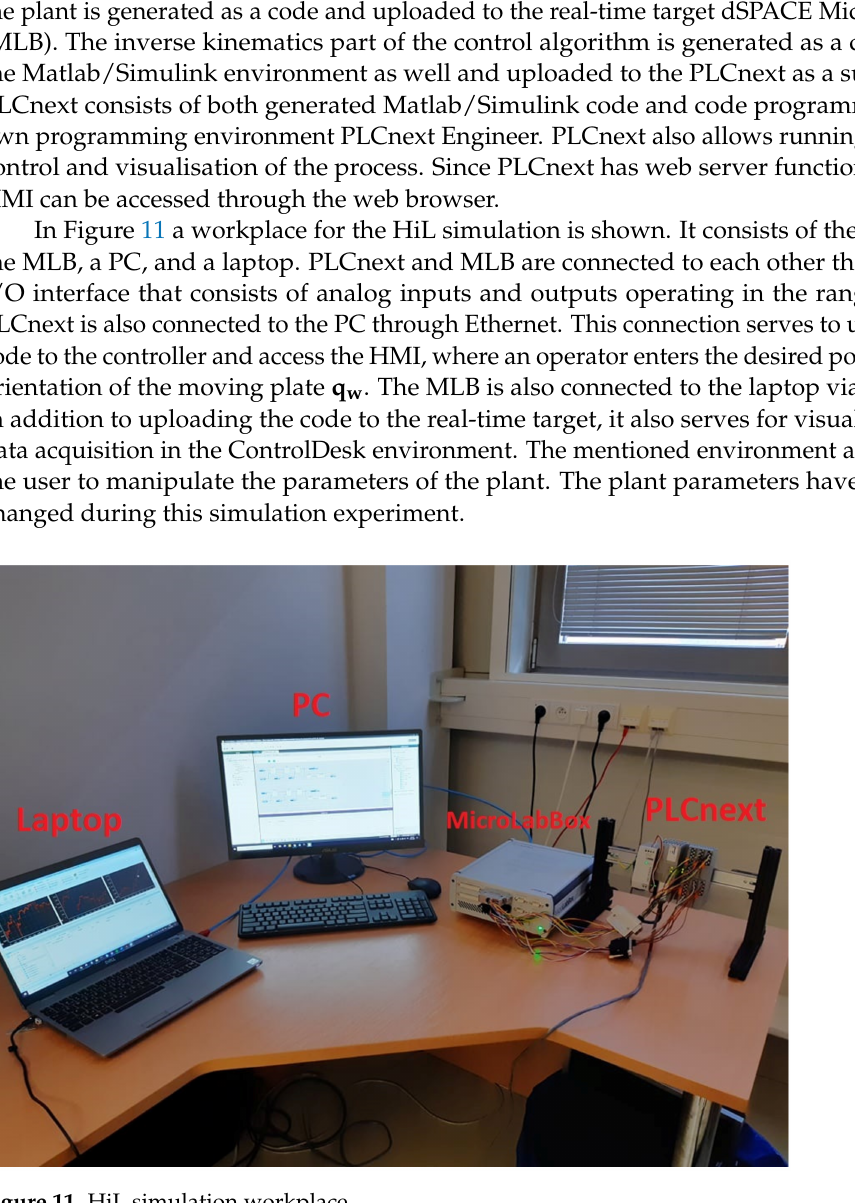
Figure 11. HiL simulation